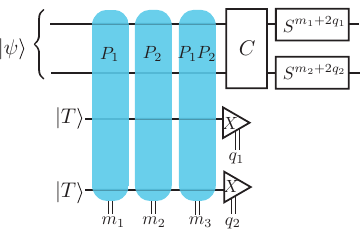
FIG. 12. A simple TELS protocol: it is an error-detecting ver- sion of the PBC used in Fig. 2, using the measurement code given in Eq. (14). While this approach uses three multiqubit Pauli mea- surements, the capability to detect an error means that lattice surgery can be executed over a shorter time d m . If there is no error, we have that the measurement outcomes obey m 1 ⊕ m 2 = m 3 . When an error is detected, we simply remeasure the Pauli